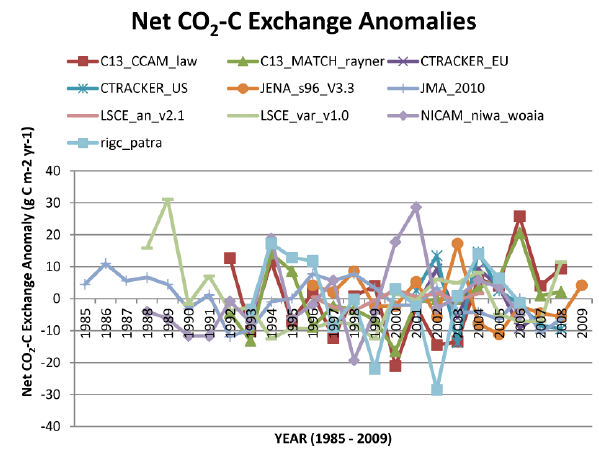
Fig. 8. Comparison among inversion model estimates of the inter- annual variability between 1985 and 2009 for anomalies of the net annual exchange of CO 2 between arctic tundra and the